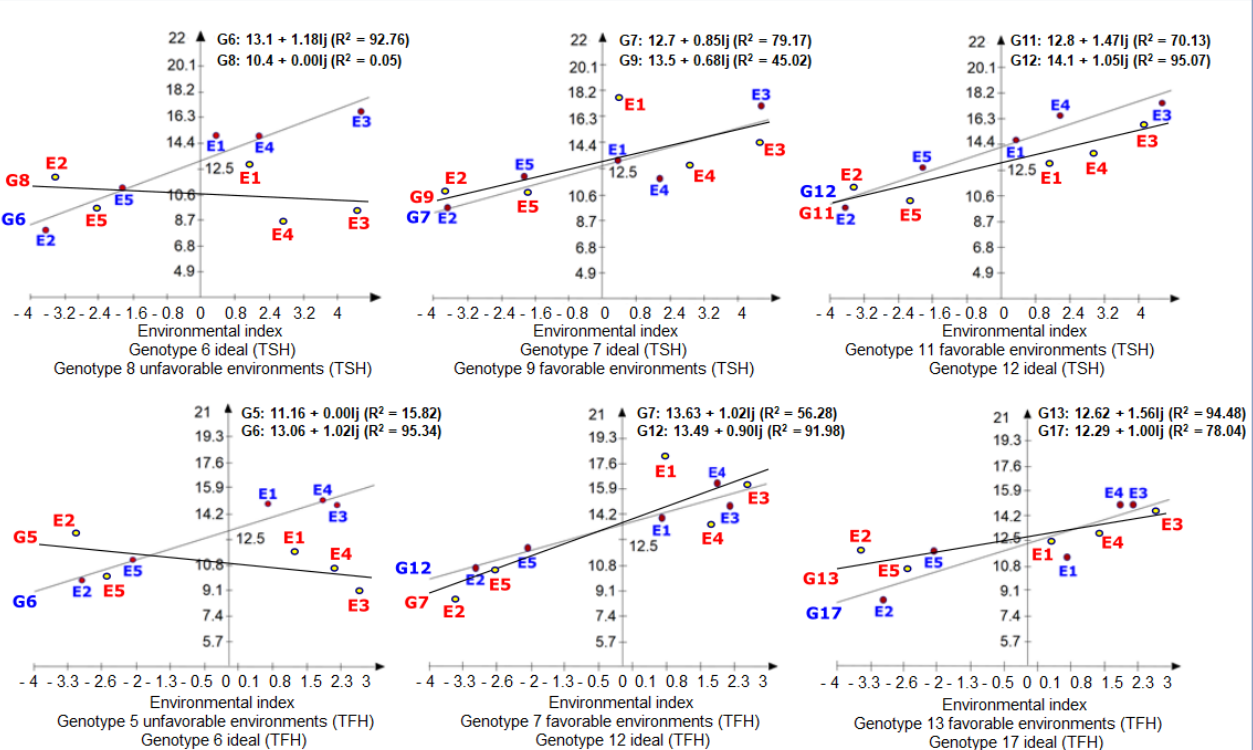
Figure 3. Average performance of ideal genotypes, genotypes for favorable and infavorable environments for the traits TSH and TFH in function of the environmental index and the regression line adjusted by Eberhart-Russel method.